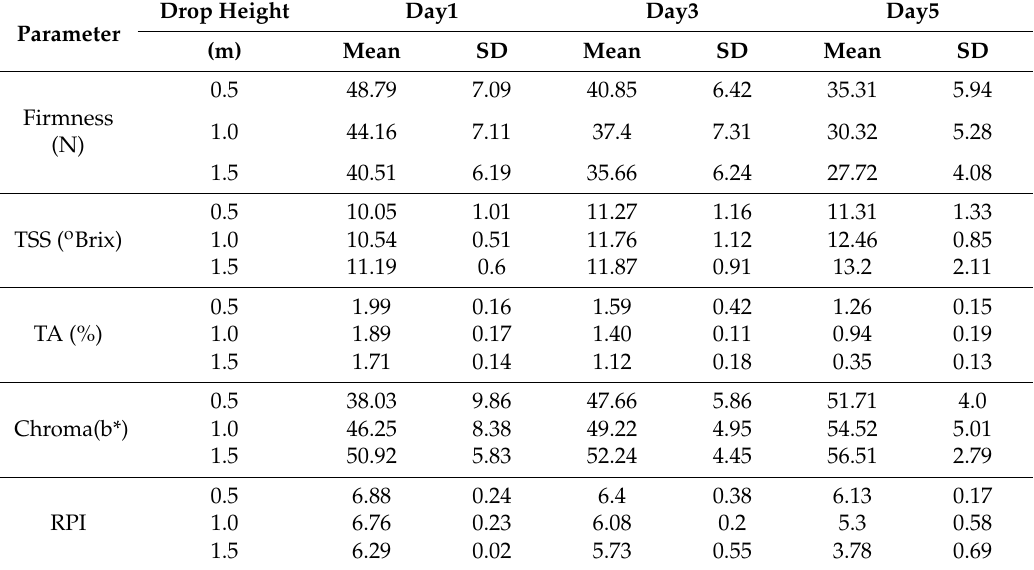
Table 1. The statistical parameters of measured quality attribute data of all mango samples. Parameter